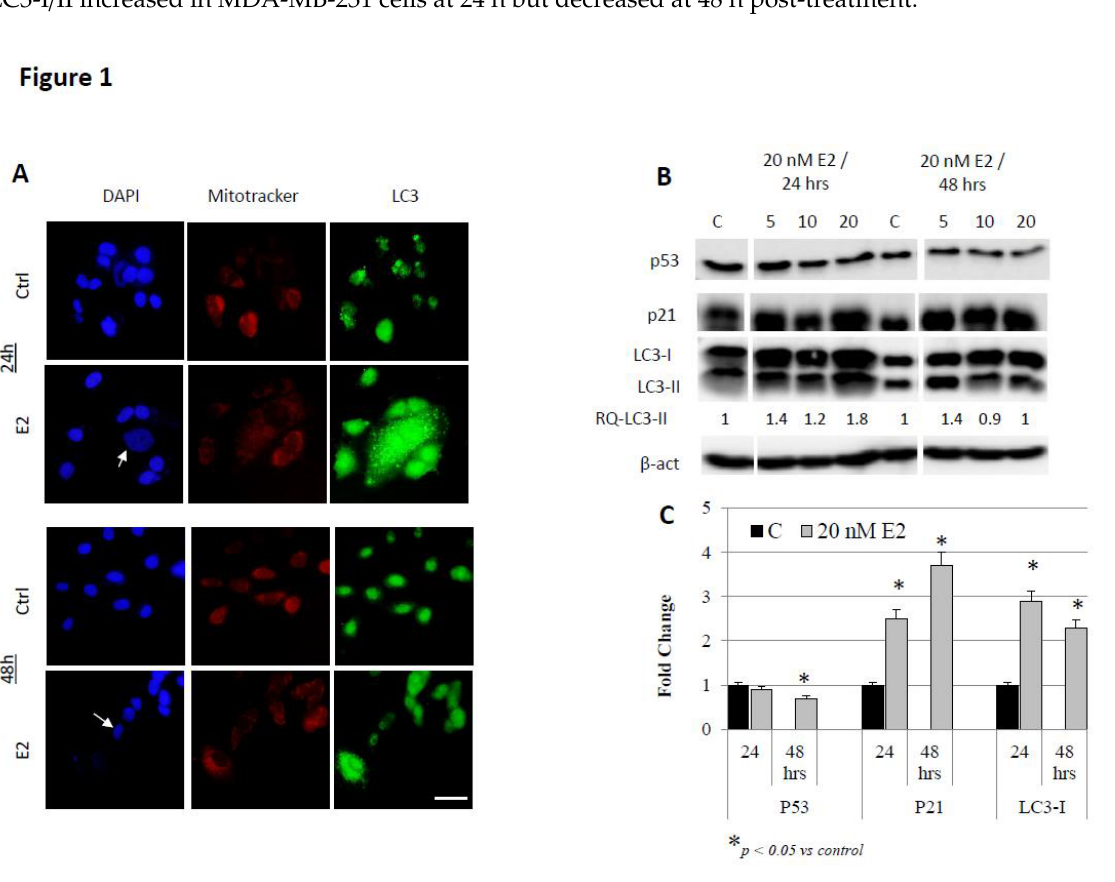
Figure 1. Mitochondrial accumulation and autophagy in E2-treated MCF-7 cells. ( A ) Cells treated with 20 nM E2 or left untreated for 24 or 48 h were stained for DNA (DAPI; blue), mitochondrial accumulation (mitotracker; red) and LC3 (green); images were taken at 40X magnification; scale bar (white) represents 10 µ m. Presence of SAHF (senescence-associated heterochromatin foci) in the nuclear region of senescent cells is indicated by white arrows. ( B ) Expression of cell senescence and autophagy markers P53, P21, and LC3-I / II in lysates of cells treated with 20 nM E2 for 24 and 48 h; RQ refer to LC3-II quantity under di ff erent treatment conditions relative to control. ( C ) Mean + SD fold change in protein expression in treated and untreated cells based on three separate